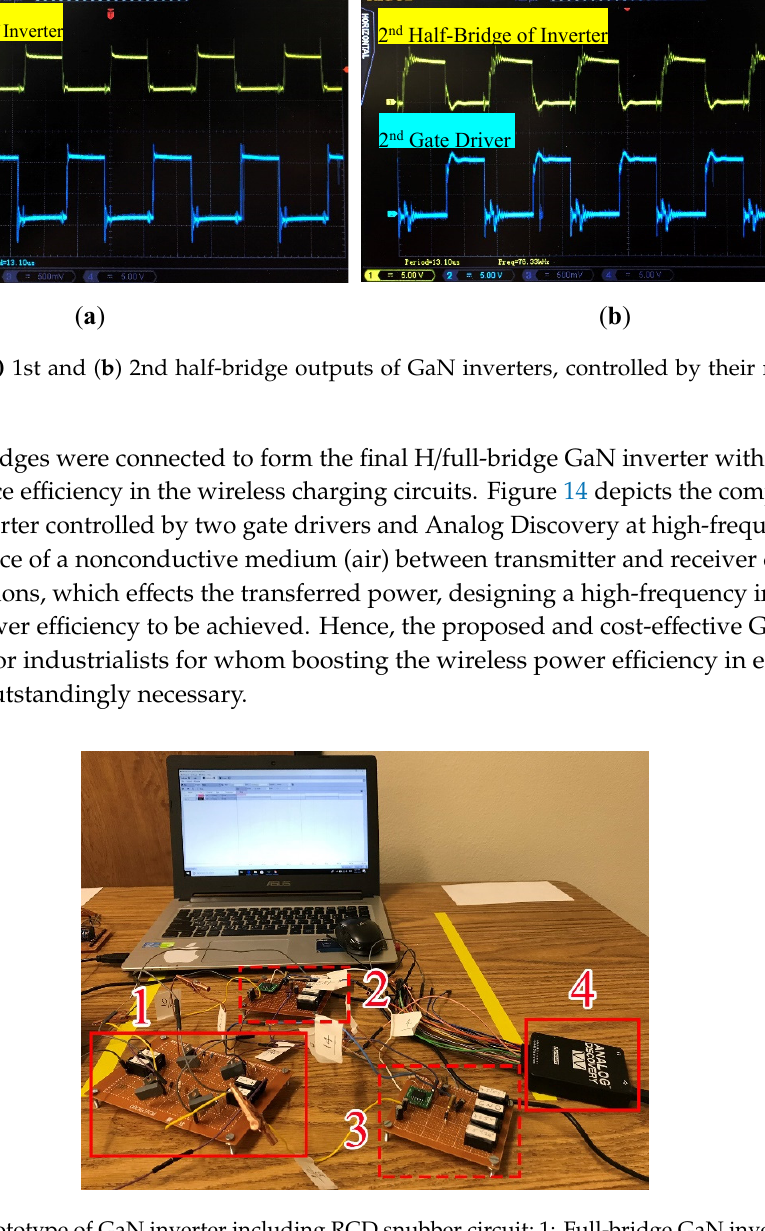
Figure 13. (a) 1st and ( b ) 2nd half-bridge outputs of GaN inverters, controlled by their respective gate drivers.